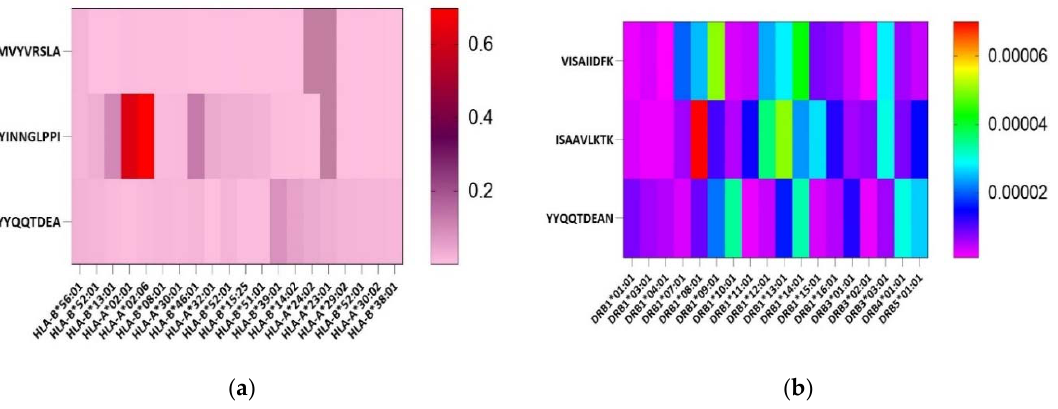
Figure 3. ( a ) Epitopes displaying a range of affinities to different human leukocyte antigen (HLA) Class I alleles. Red, purple and pink show strong, intermediate and weak, respectively. ( b ) Shows the affinity of screened epitopes with HLA Class II alleles. Pink shows the weakest while red indicates the highest binding score. Table 1. Detail of the selected epitopes and their different properties.